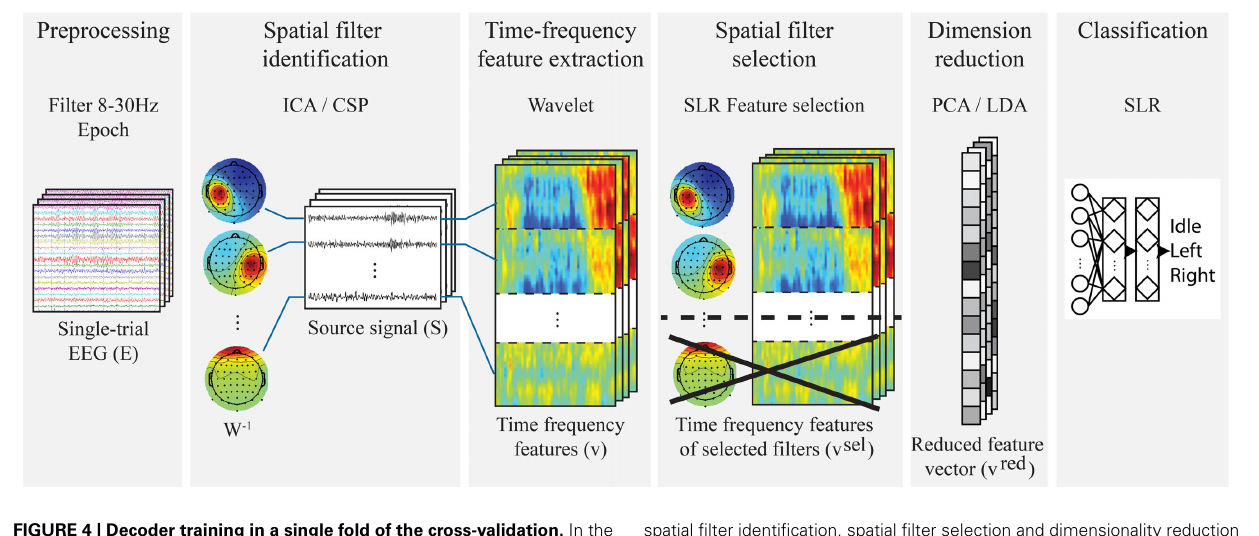
spatial filter identification, spatial filter selection and dimensionality reduction are computed only on the training set of each cross-validation fold. Moreover, the time-frequency features are vectorized in the algorithm, while in figure they are kept in matrix form for a visualization purpose: the horizontal axis represents the time, and the vertical axis represents the